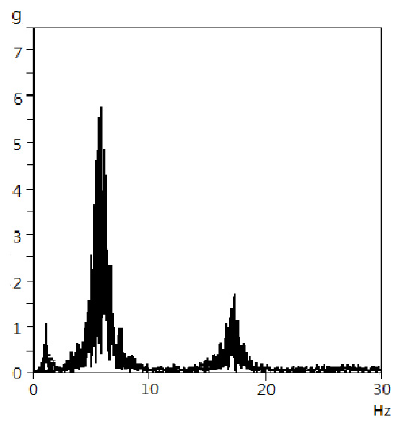
Figure 5. Beam frequency response.